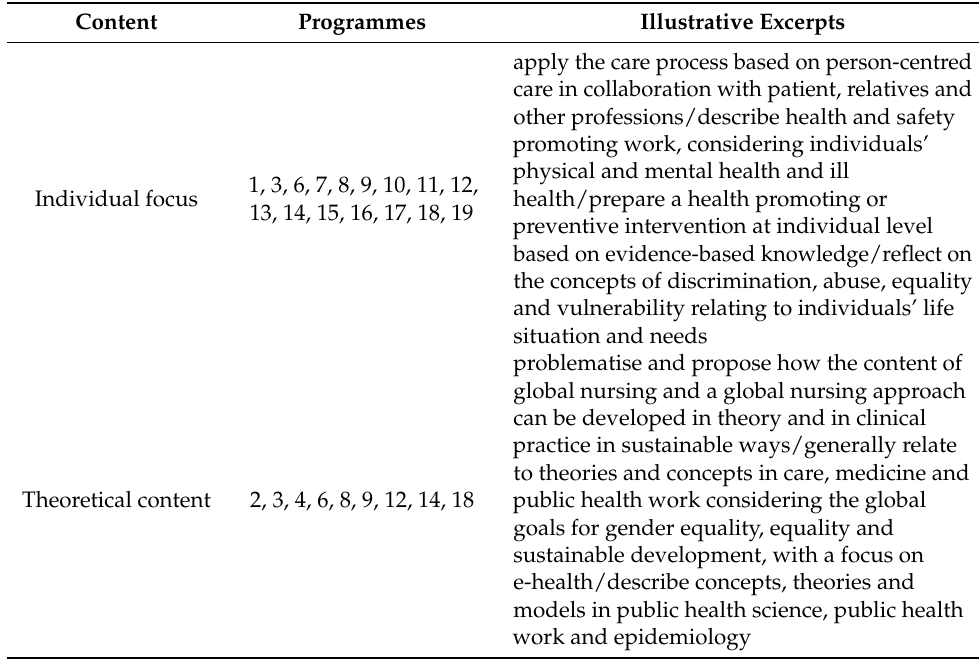
Table 7. Individual focus and theoretical content in the